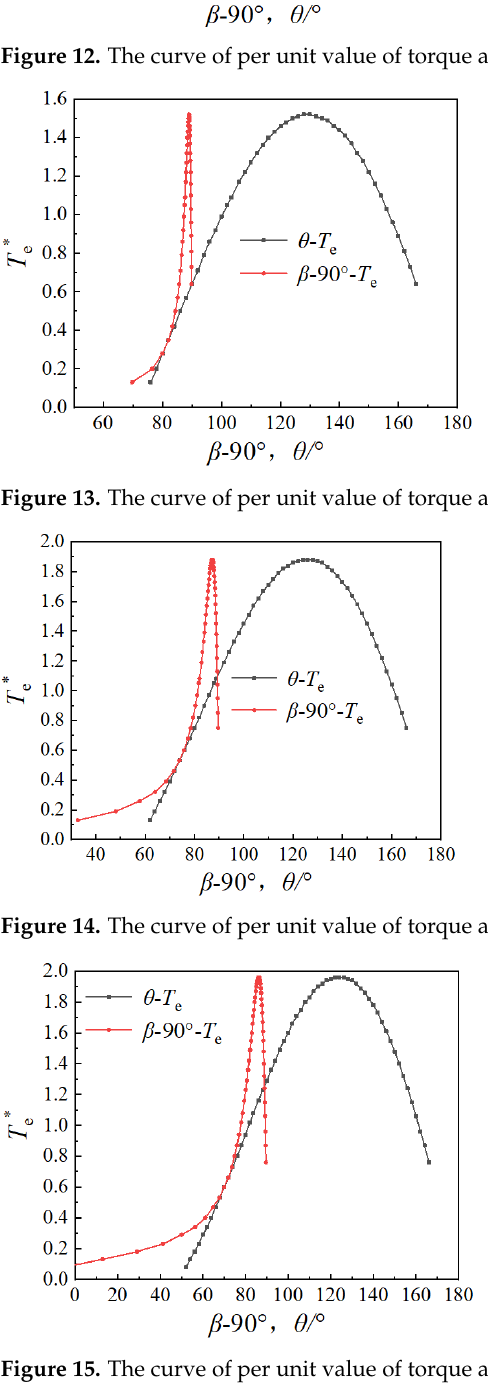
Figure 16. The curve of per unit value of torque at λ = 0.8. Figure 17. The load rate curve with different λ. The load rate and value of λ basically change linearly, and the minimum current state at any load point can be obtained by selecting the reasonable parameters according to the curve.